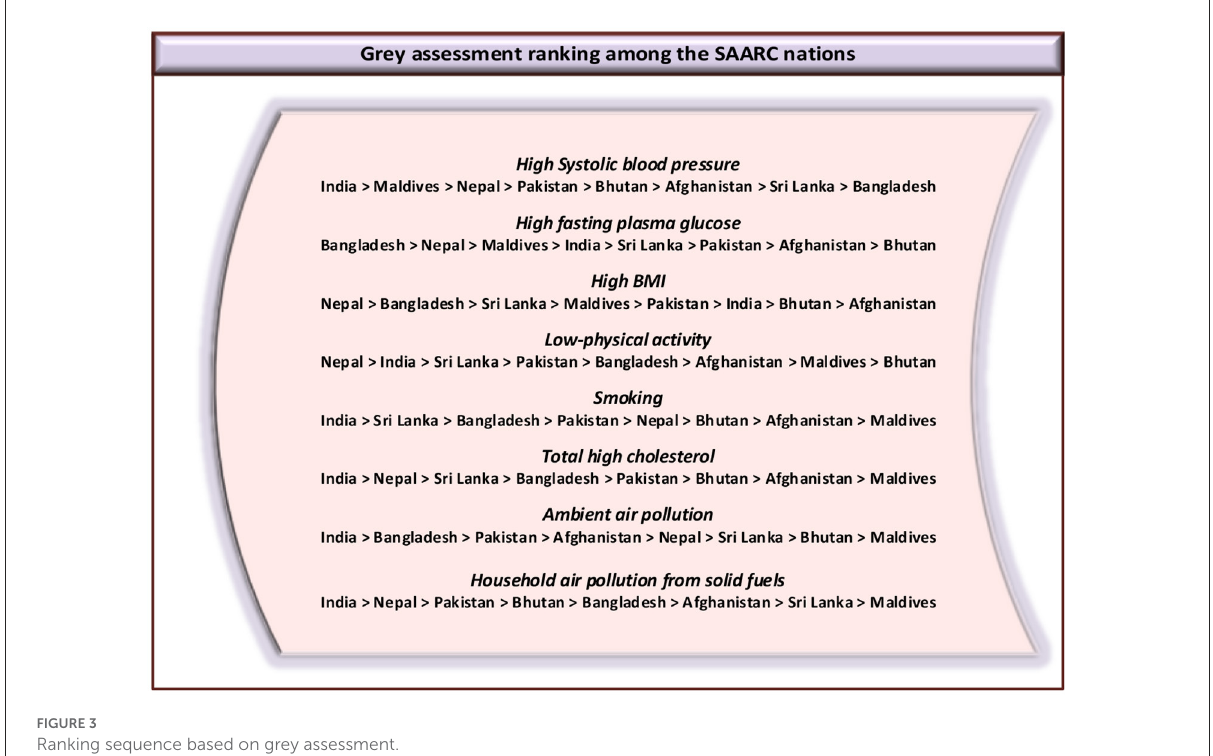
FIGURE3 Ranking sequence based on grey assessment.